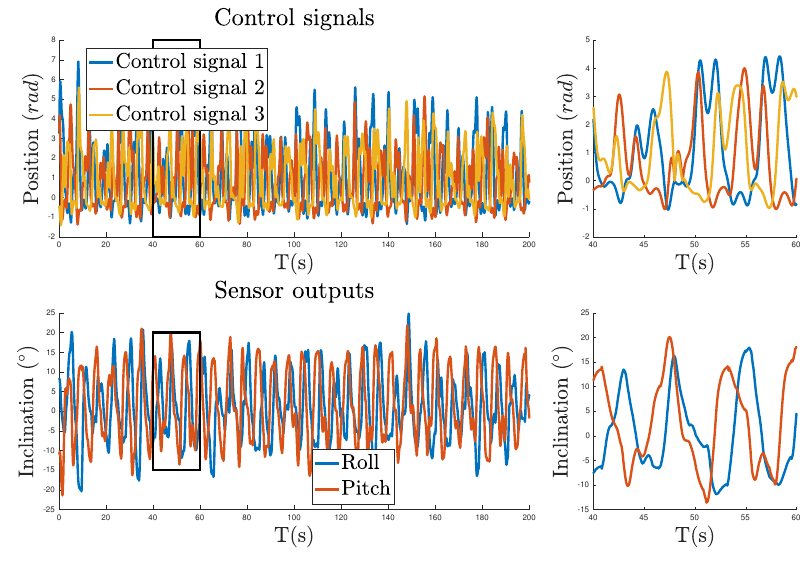
Figure 4. Input and output